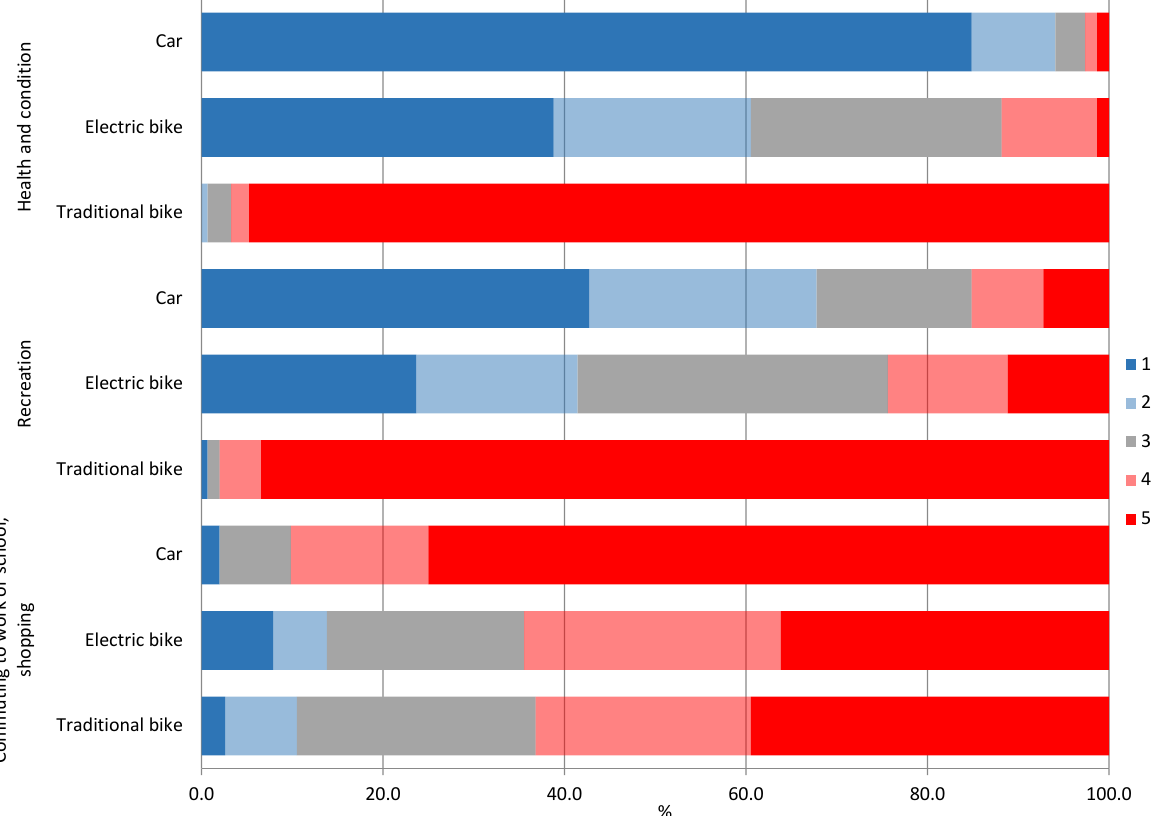
Figure 2. Structure of answers to the question: “Assuming you have access to both a traditional bicycle and an e-bike, please indicate which one you would use in each situation?” Source: Own elaboration on the basis of the questionnaire survey.